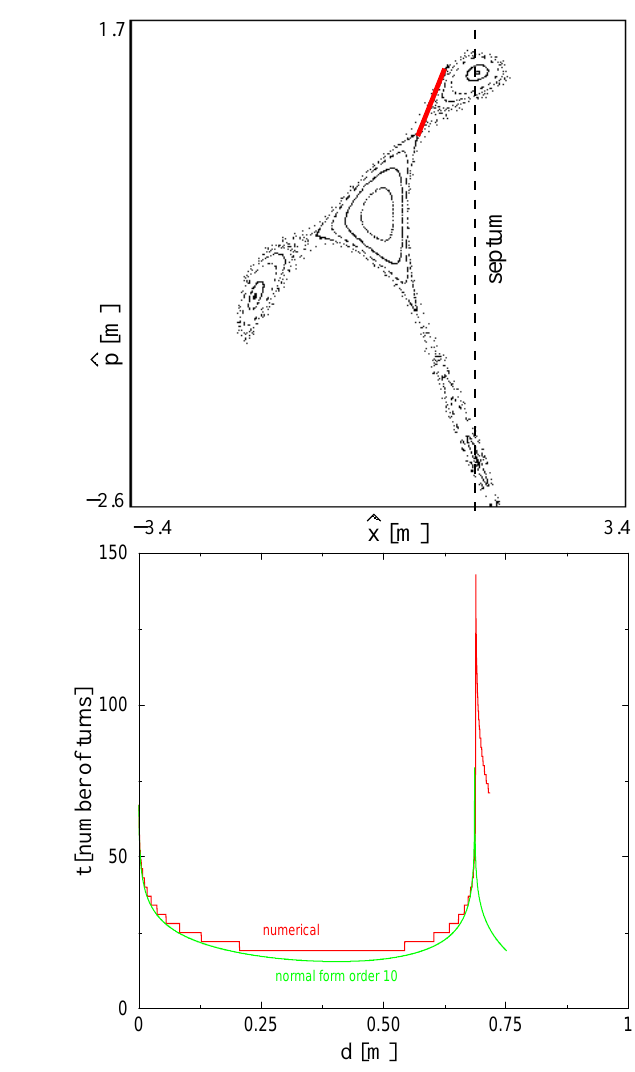
FIG. 2. (Color) (Top) Phase plot in linearly normalized coordi- nates (cid:2) ˆ x , ˆ p (cid:3) for a sextupole ˆ K 2 (cid:1) 1 m 2 1 and linear frequency v 0 (cid:1) 4.32 3 2 p . (Bottom) Numerical (red line) and analyti- cal tenth-order (green) estimates of the extraction time for a distribution of particles on a line versus the distance from the hyperbolic fixed point. The extracted points initially belong to the red segment in the phase space plot. The dynamic aperture is ˆ x dyn (cid:1) 570 mm. The corresponding value in physical coor- dinates is x dyn (cid:1) 110 mm, and for the value ˆ K 2 (cid:1) 4.6 m 2 1 of SIS becomes x dyn (cid:1) 24 mm, just as the core radius a at the be- ginning of the extraction.